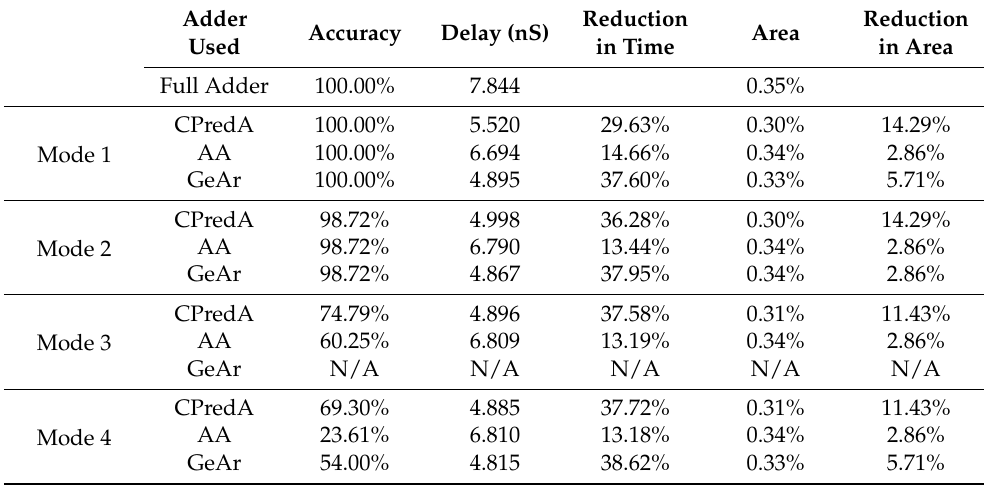
Table 6. Evaluation results for all